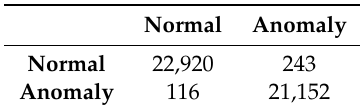
Table 29. Confusion matrix for Adaboost Random Forest.